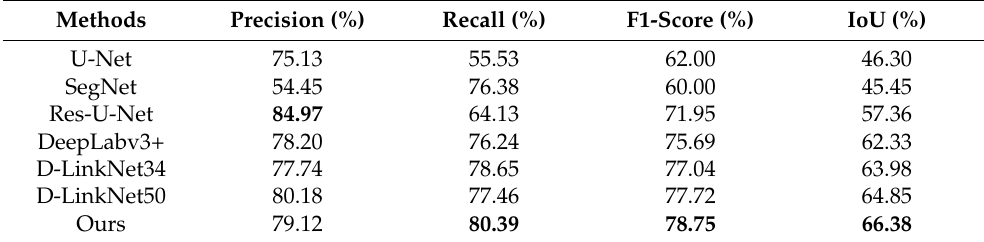
Table 3. The performance comparison of related methods on the DeepGlobe test